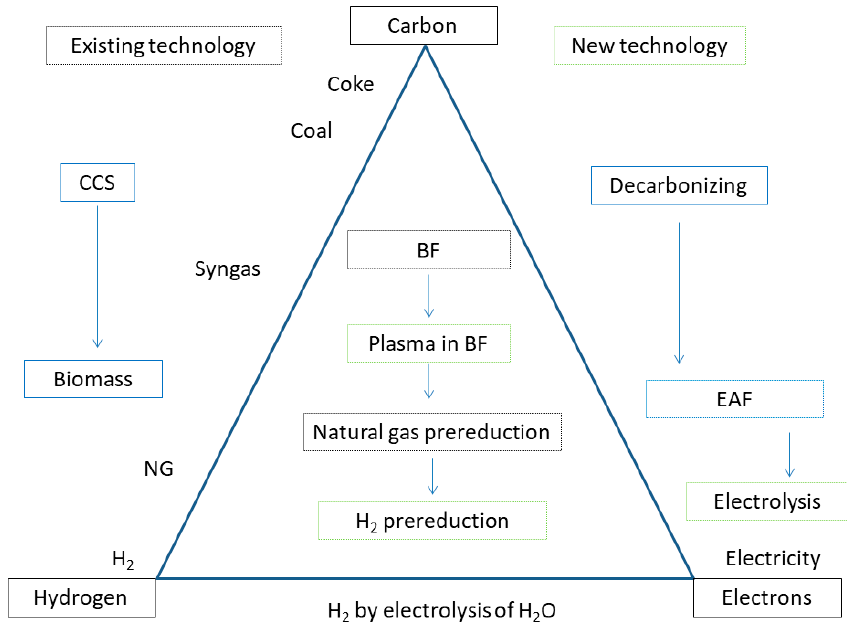
Figure 1. Pathways of technologies for greenhouse gases emissions abatement.